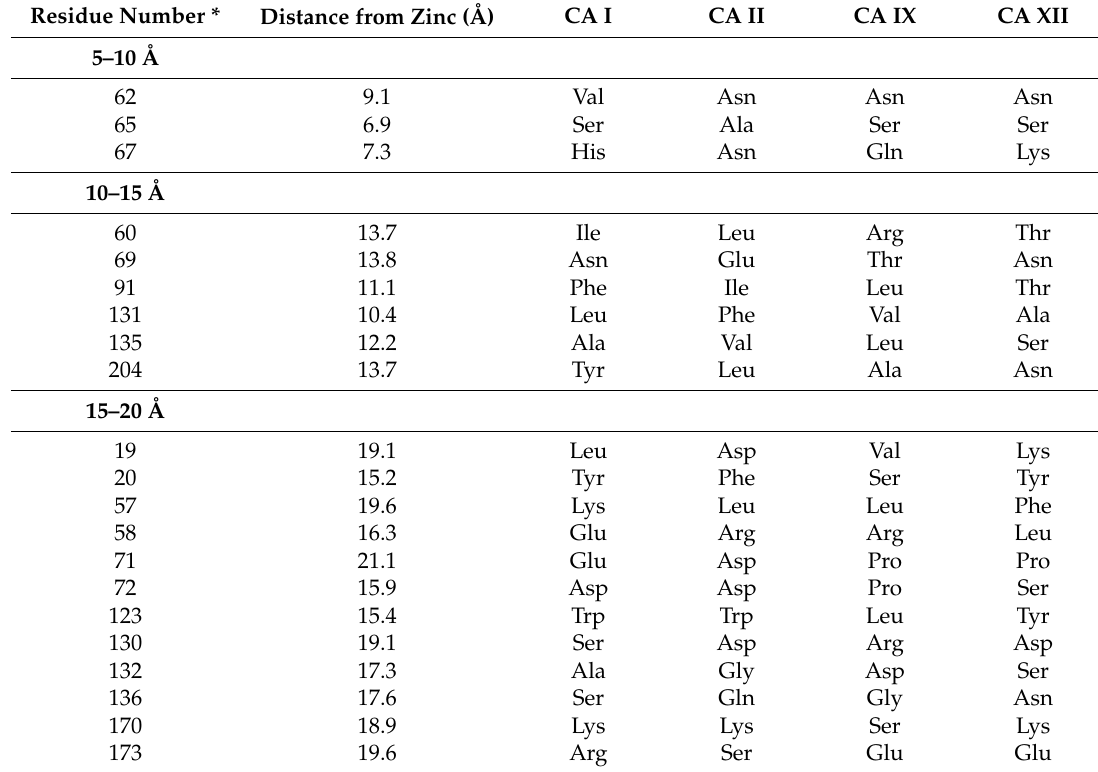
Figure 7. Surface representation of CA II with various zones and pockets. Active site zinc shown as magenta sphere. ( A ) Various zones within the active site (distance from zinc): Zone I (5–10 Å) in yellow, Zone II (10–15 Å) in cyan and Zone III (15–20 Å) in pink. Three pockets within and around active site encircled in red dashes. ( B ) An inhibitor extending out of the active site in Zone III (15–20 Å shown in pink) of CAII (unpublished). Table 4. Residue differences between CA isoforms. (CA II numbering used) [11,68].